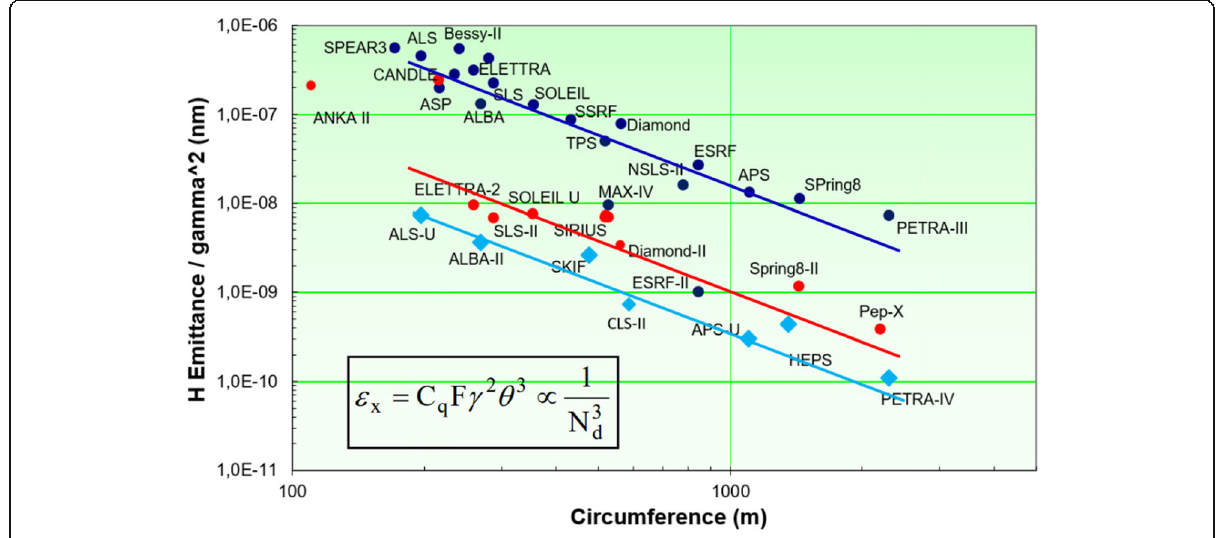
Fig. 9 Storage ring distributions along circumference [25]